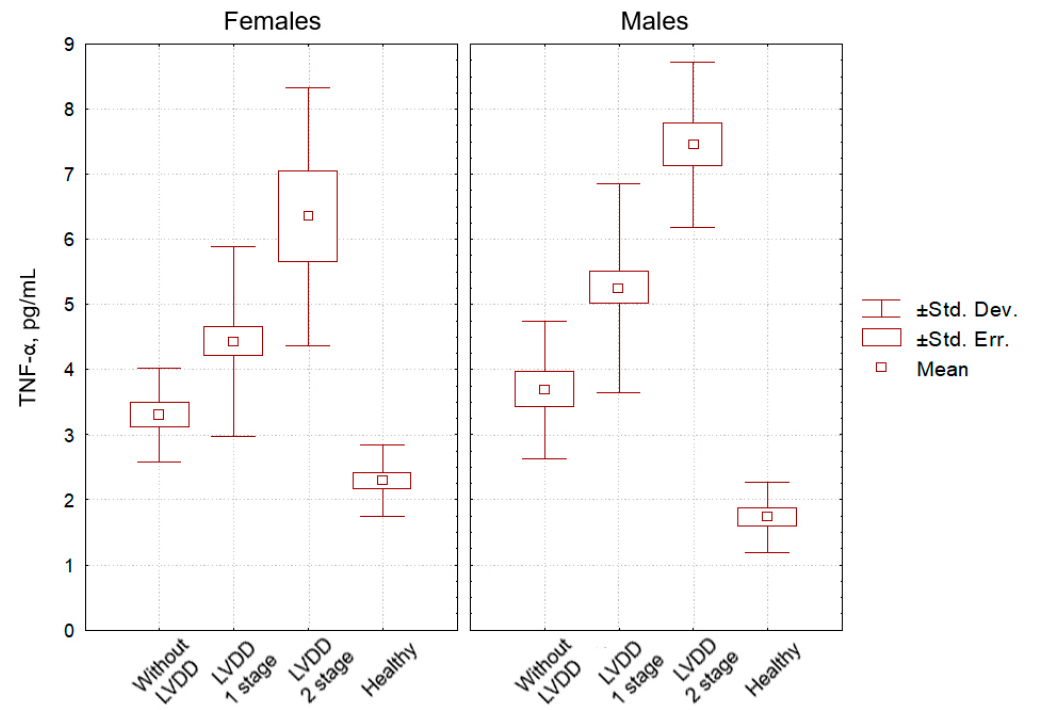
Figure 4. Indicators of TNF- α level in the blood (pg/mL) in patients with hypertension without CHF and LV diastolic dysfunction (comparison group), patients with hypertension with CHF and LV diastolic dysfunction of the 1st and the 2nd stages, and healthy individuals (control group), taking into account participants’ gender.